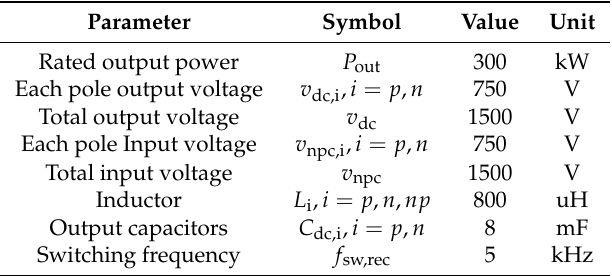
Table 2. Design specifications of the DC/DC converter